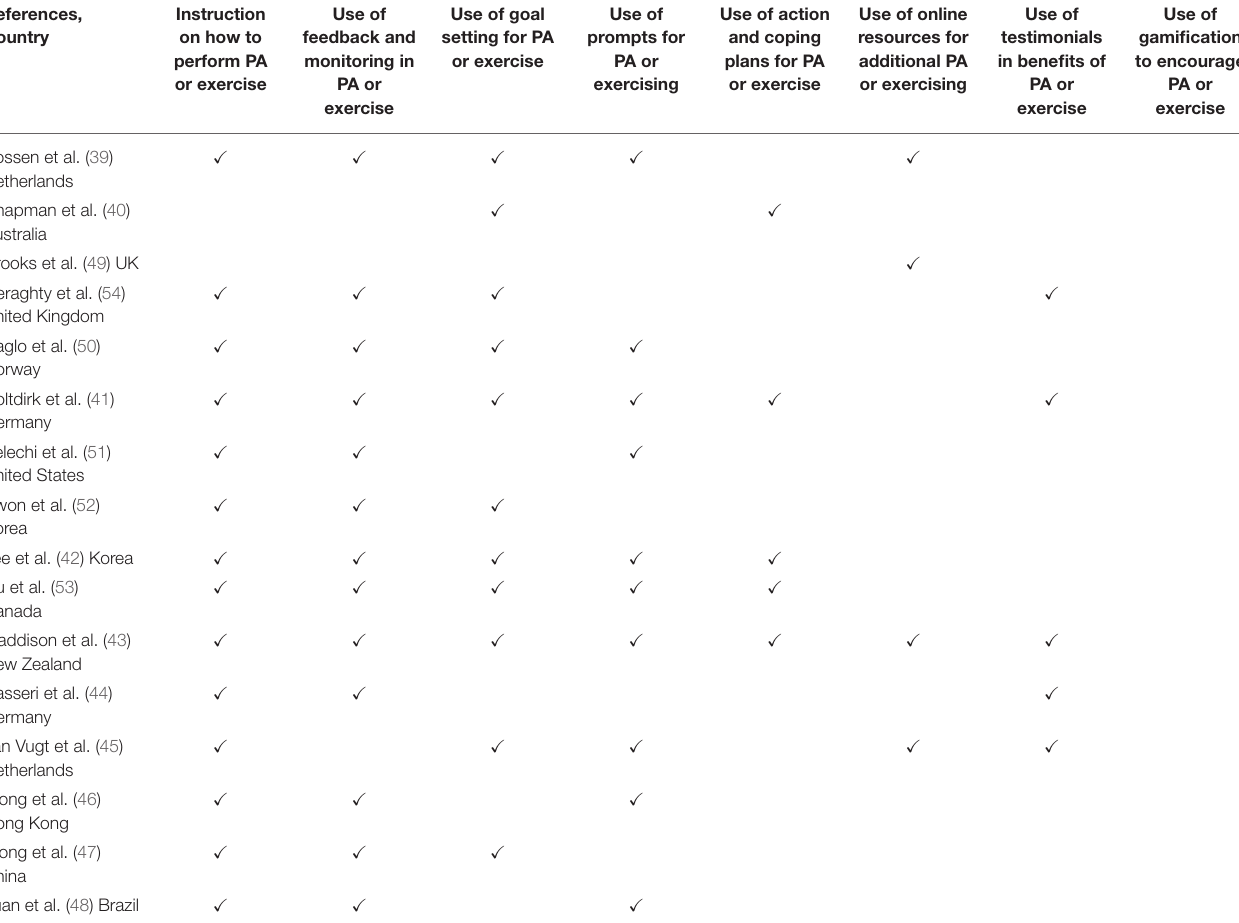
TABLE 4 | Behavioral intervention features and strategies